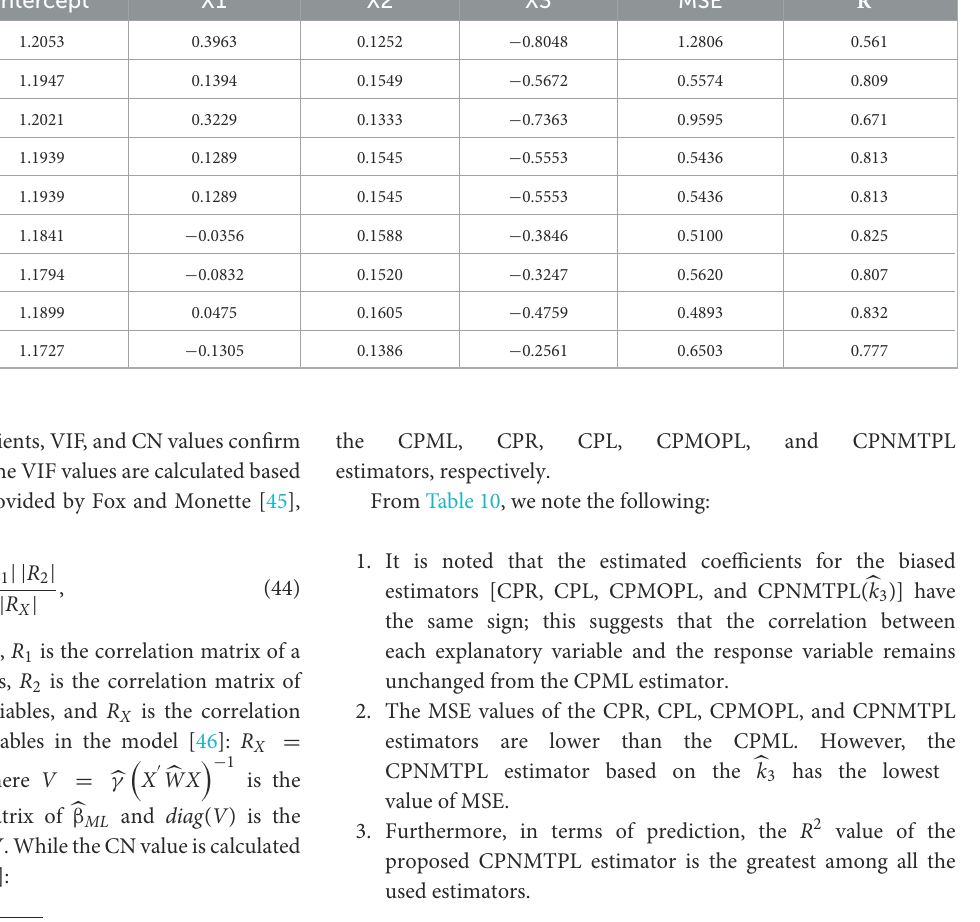
TABLE 10 Estimated coefficients, MSE, and R 2 .